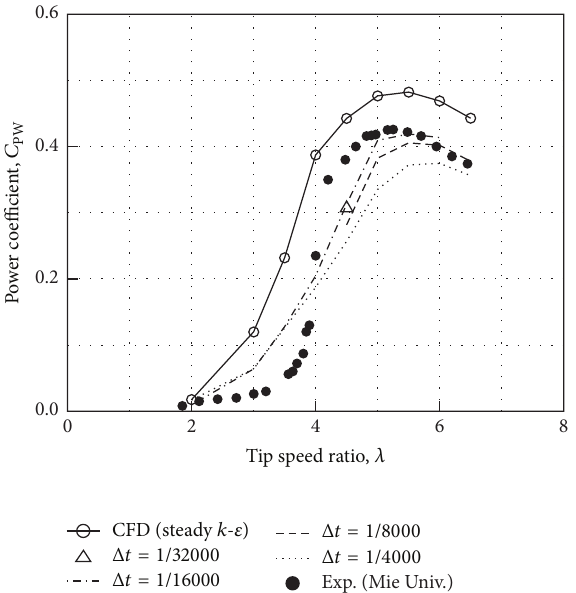
Figure 4: Power coefficient compared with experimental data.